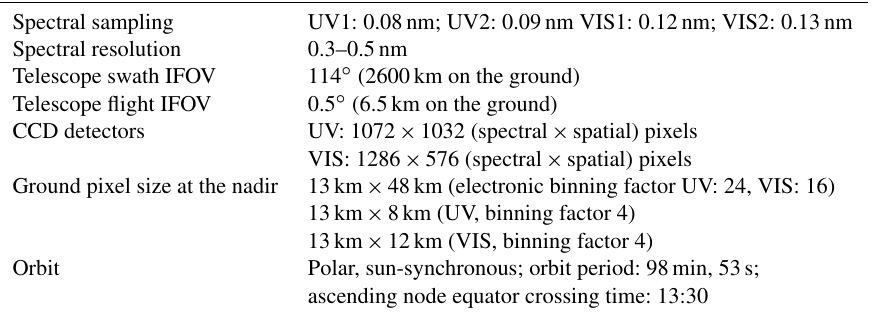
Table 1. EMI instrument properties.